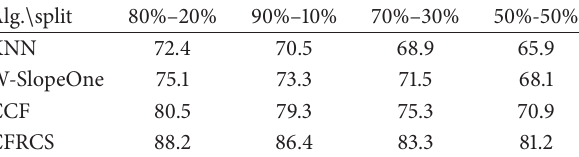
Table 3: Comparison results of different methods (DOA %).